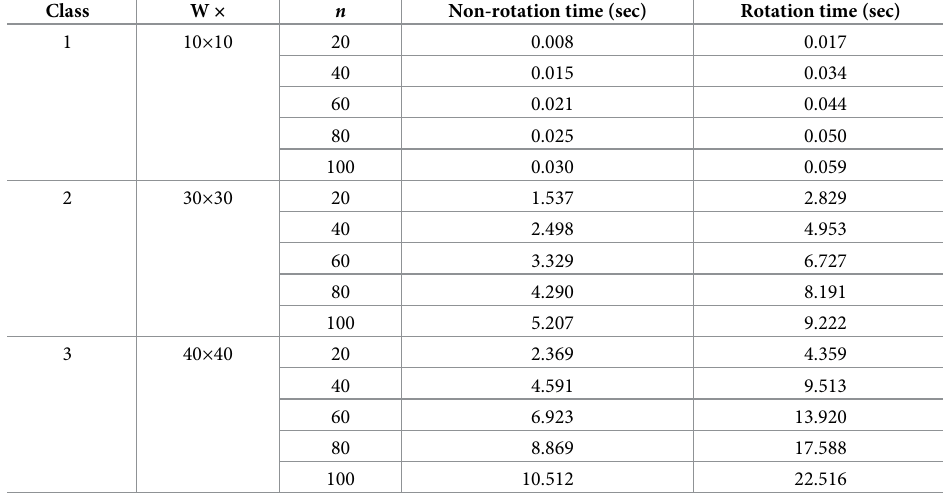
Table 3. Execution time for the Positions stage of P&C, Algorithm 1, for the instances in Classes 1–3 of bwmv with and without